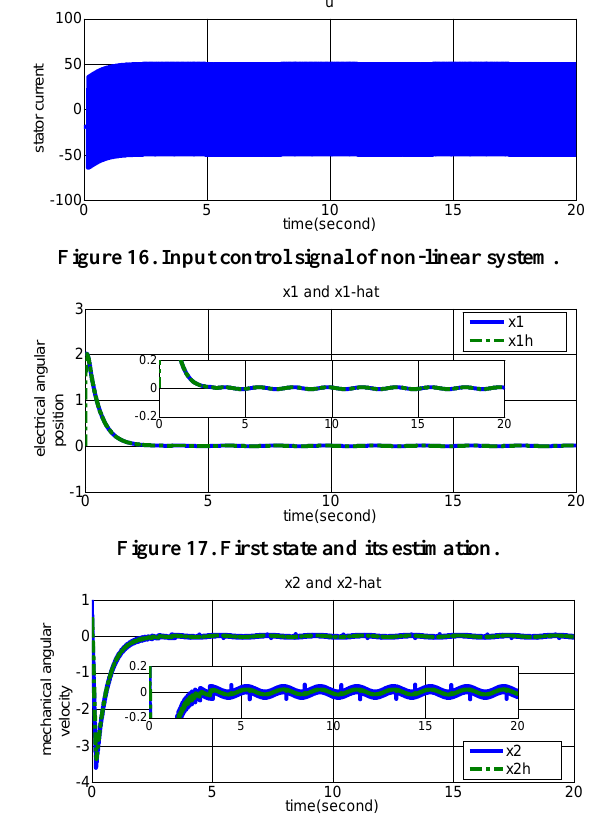
Figure 15. Difference between non-linear system and its fuzzy estimation.